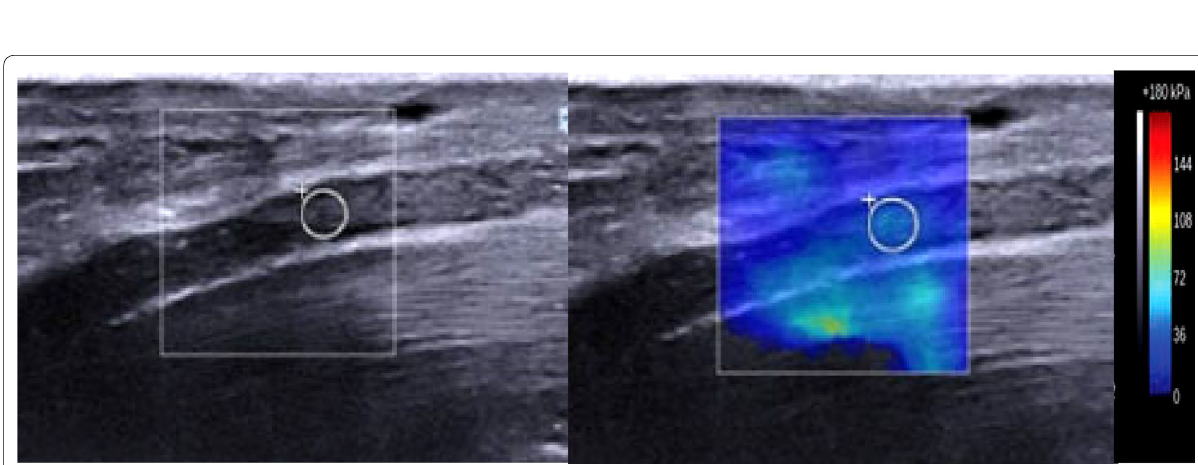
Fig. 2 A 45-year-old female patient with moderate grade of carpal tunnel syndrome by electrophysiological diagnostic studies. ( Left ) High-resolution conventional B-mode ultrasound showed thickened median nerve with increased CSA (12.8 mm 2 ), and wrist/forearm ratio (2.7). ( Right ) Shear-wave elastography of the median nerve displayed increased mean median nerve stiffness value